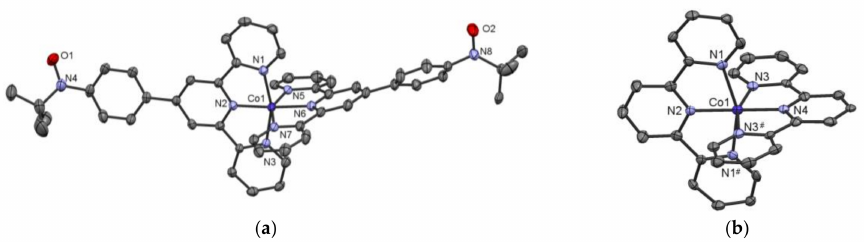
Figure 1. X-ray crystal structures of [Co(L) 2 ](CF 3 SO 3 ) 2 (L = ( a ) tpyphNO; ( b ) tpy), measured at 90